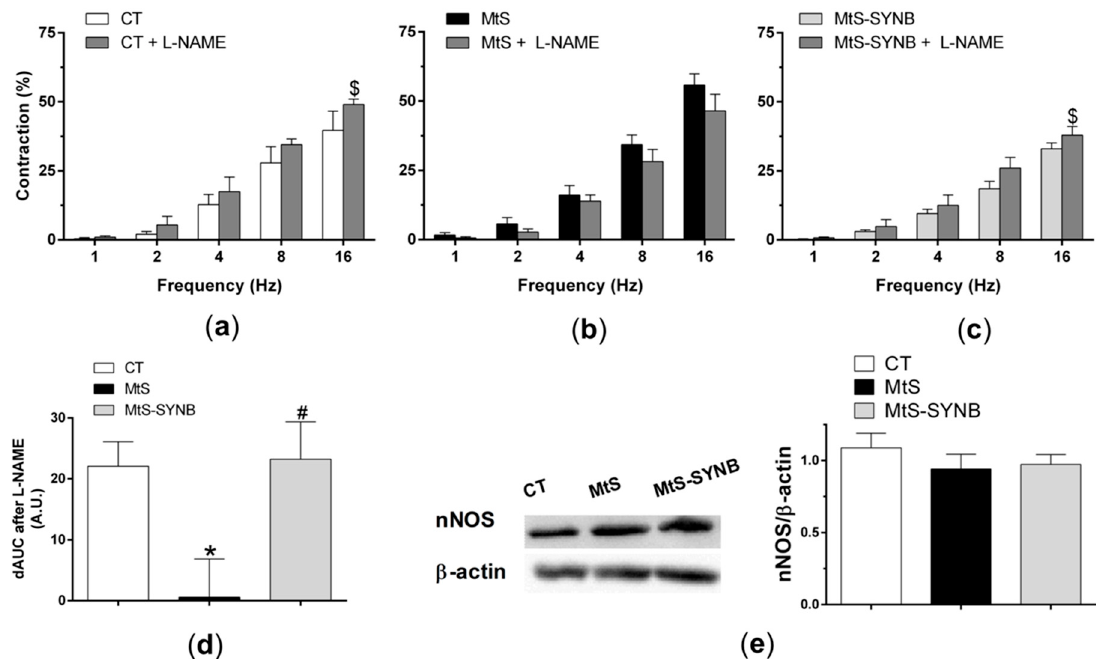
Figure 6. Effect of preincubation with 0.1 mmol/L L-NAME (non-specific NOS inhibitor) on the vasoconstrictor response elicited by EFS in mesenteric segments from CT ( a ), MtS ( b ) and MtS-SYNB ( c ) rats. Results (mean ± S.E.M.) are expressed as a % of previous contraction elicited by KCl. Statistical analysis: Paired two-way ANOVA. $ p < 0.05 segments without L-NAME vs. segments with L-NAME. ( d ) Differences of area under the curve (dAUC) in the absence or presence of 0.1 mmol/L L-NAME. Statistical analysis: One-way ANOVA followed by a Newman–Keuls post-hoc test. * p < 0.05 CT vs. MtS; # p < 0.05 MtS vs. MtS-SYNB. ( e ) Expression of nNOS in mesenteric segments from CT, MtS and MtS-SYNB rats. The blot is representative of eight separate segments from each group. The graph on the right shows densitometric analyses of nNOS expression. Results (mean ± S.E.M.) are expressed as